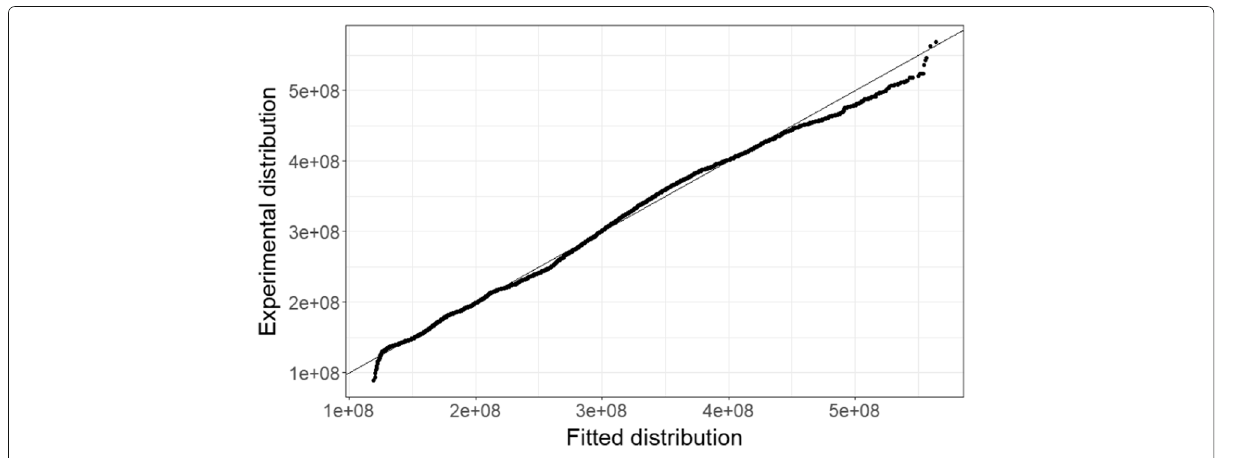
Fig. 14 QQ-plot of the data vs. the fitted distribution